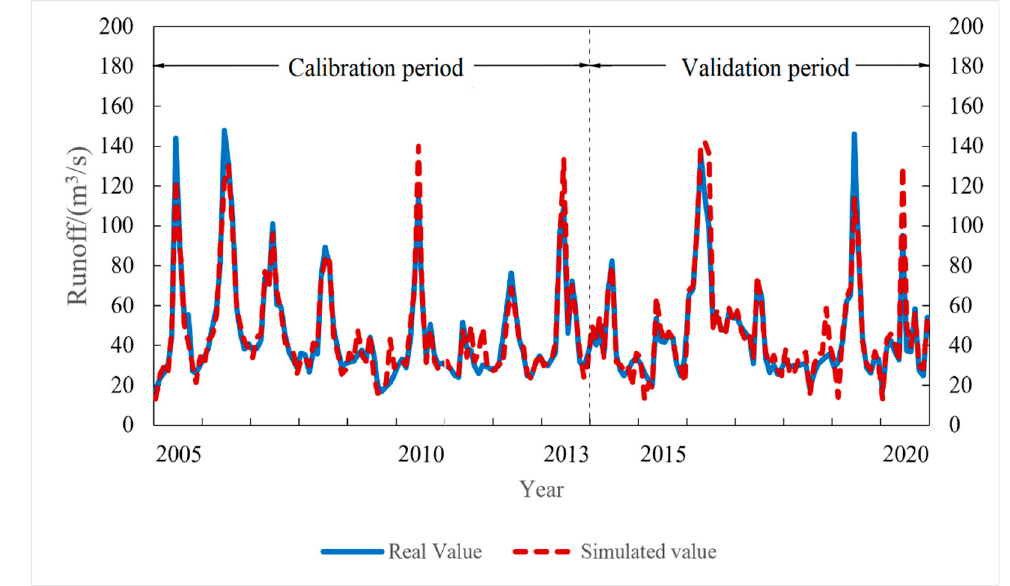
Figure 2. Simulated and real monthly runoff yield in calibrate period (2005–2013) and